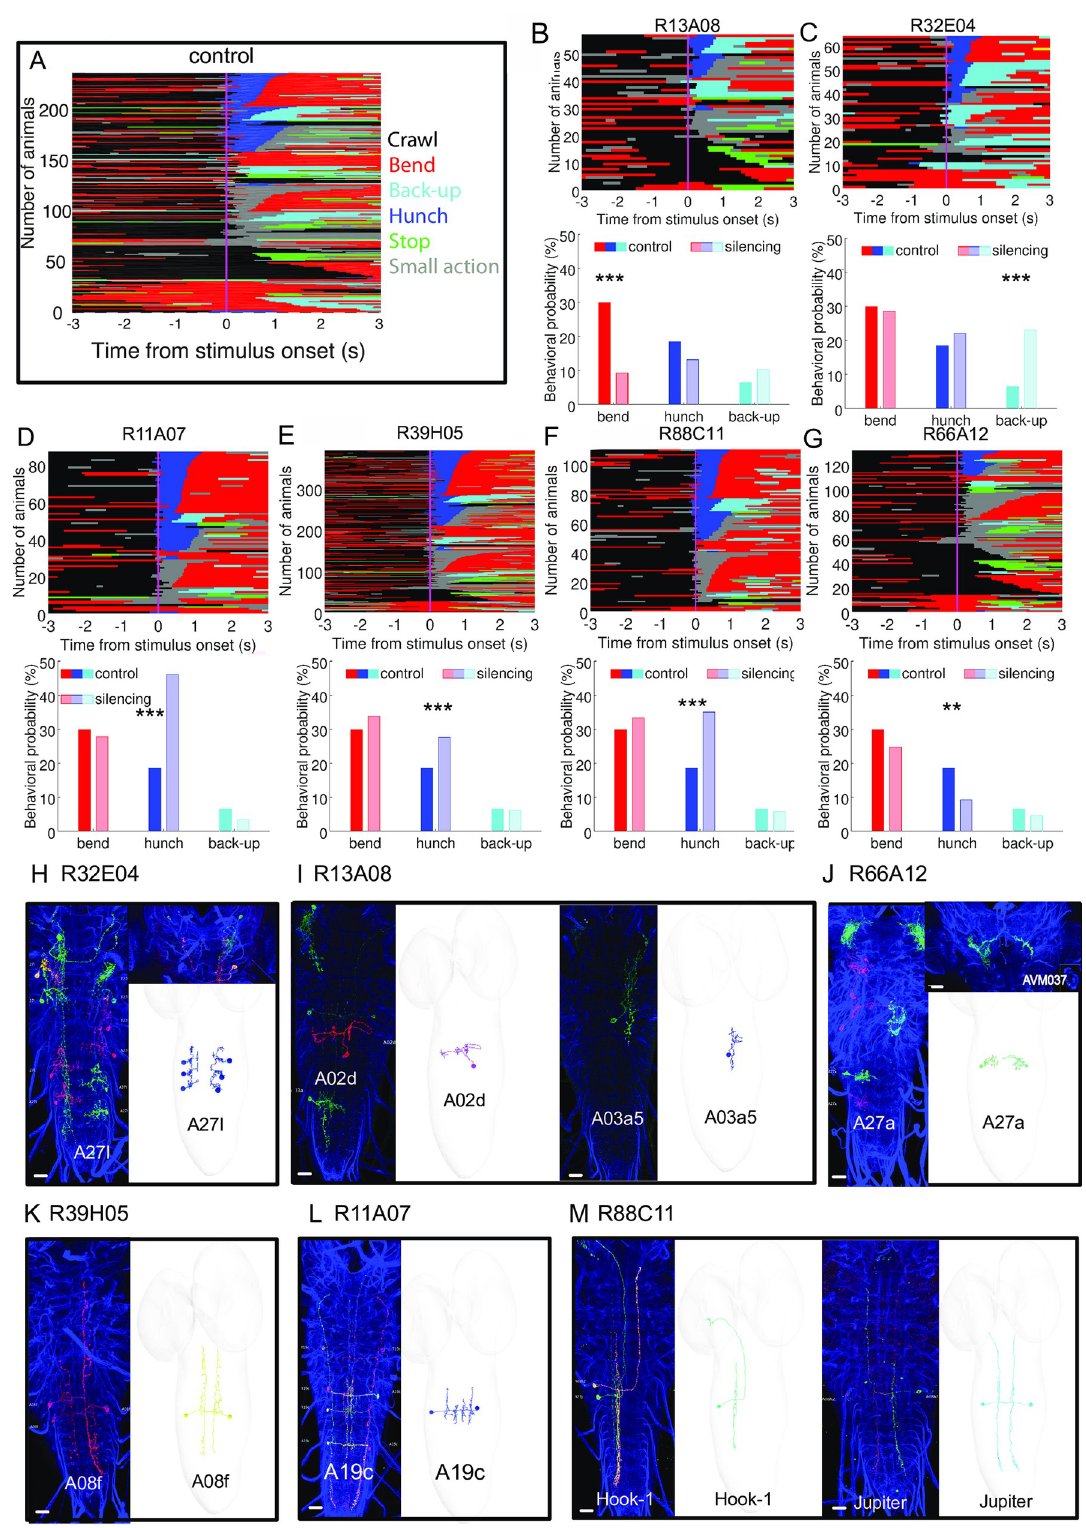
Fig 4. Candidate first order interneurons and premotor neurons involved in mechanosensory responses. A Ethogram of the air- puff response of randomly selected ca 200 control (w;; attP2-TNT) larvae for 3s prior and after stimulus onset. The larvae are sorted as